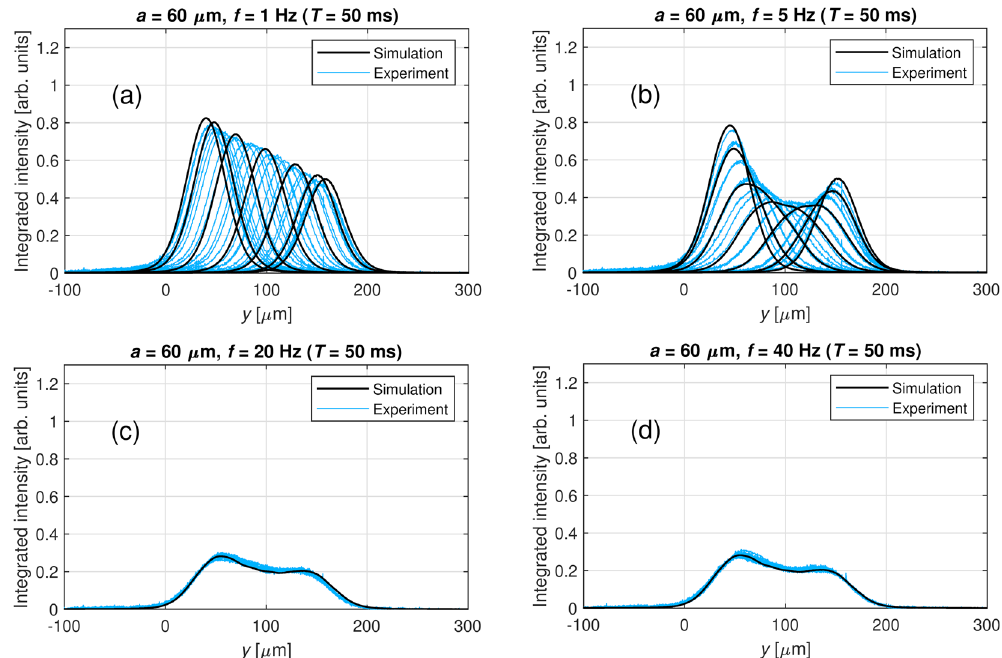
FIG. 11. Integrated intensity (vertical) with a pinhole misalignment of 100 μ m from the experiment (blue lines) and simulation (black lines). The beam was excited with an amplitude of 60 μ m and frequencies of (a) 1 Hz, (b) 5 Hz, (c) 20 Hz, and (d) 40